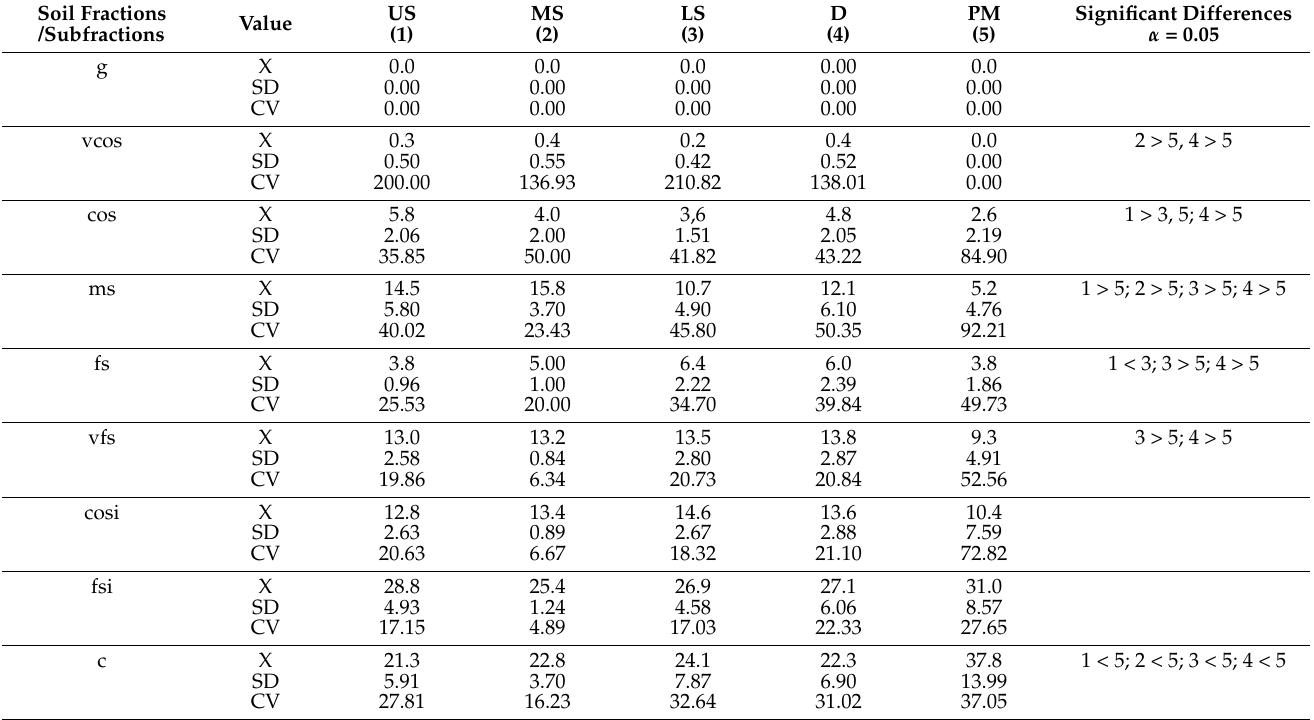
Table 4. Average amounts of soil fractions in humus horizons and parent materials in ice-dammed lakes landscape, regarding the soil position at the